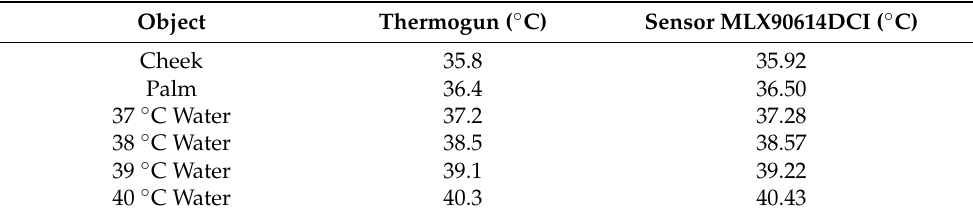
Table 1. Comparison of temperature measurements using a thermogun and MLX90614-DCI sensor.